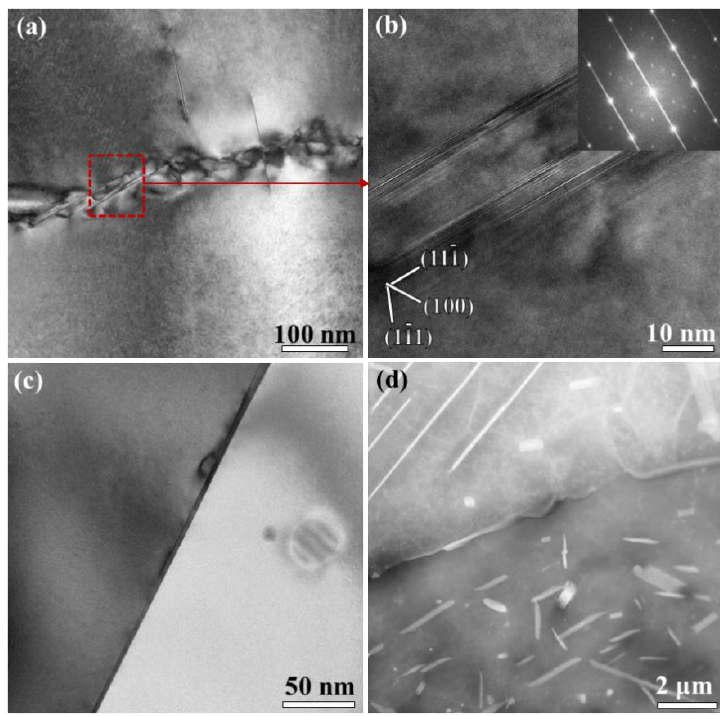
Figure 6. TEM images of the precipitates at sub-boundary and grain boundary in 2A97 alloy that solution treated at 520 ◦ C for 1 h and cooled by AC and FC: ( a ) sub-boundary of AC; ( b ) HRTEM and FFT of the boxed region in ( a ); ( c ) grain boundary of AC; ( d ) grain boundary of